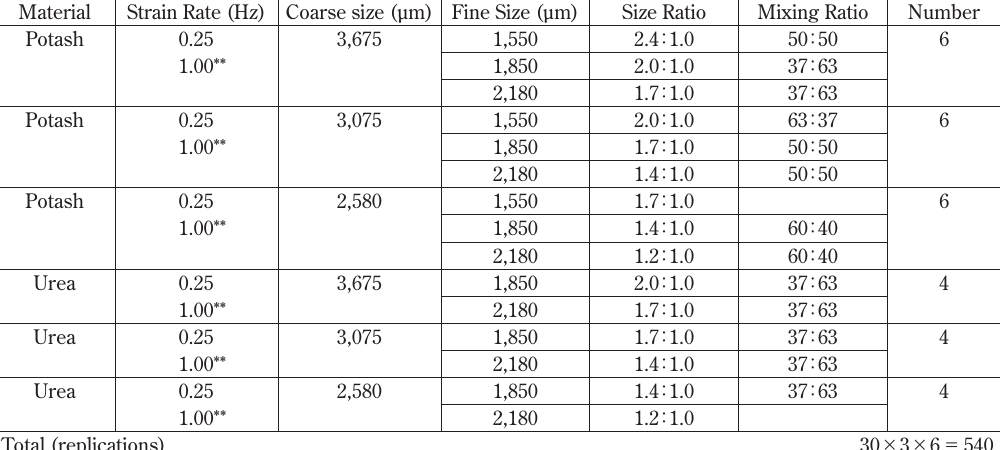
Experimental design for binary size mixtures for potash and urea *